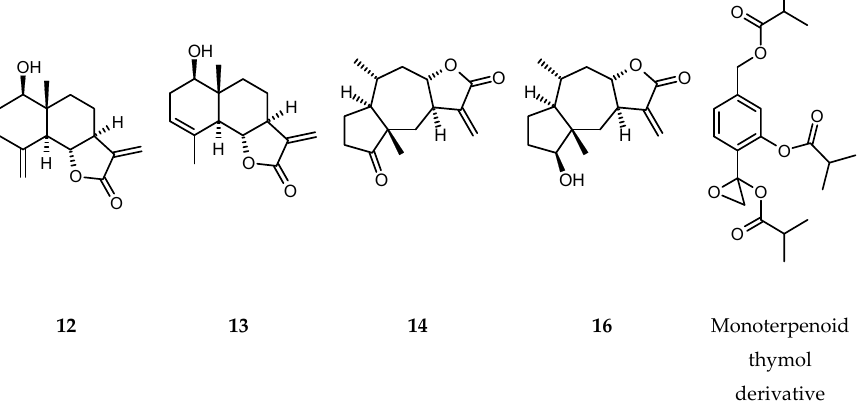
Figure 3. Chemical structures of sesquiterpene lactones ( 12 – 14 and 16 ) isolated from aerial parts of X. speciosissima and a monoterpenoid thymol derivative—7,10-diisobutyryloxy-8,9-epoxythymol isobutyrate.